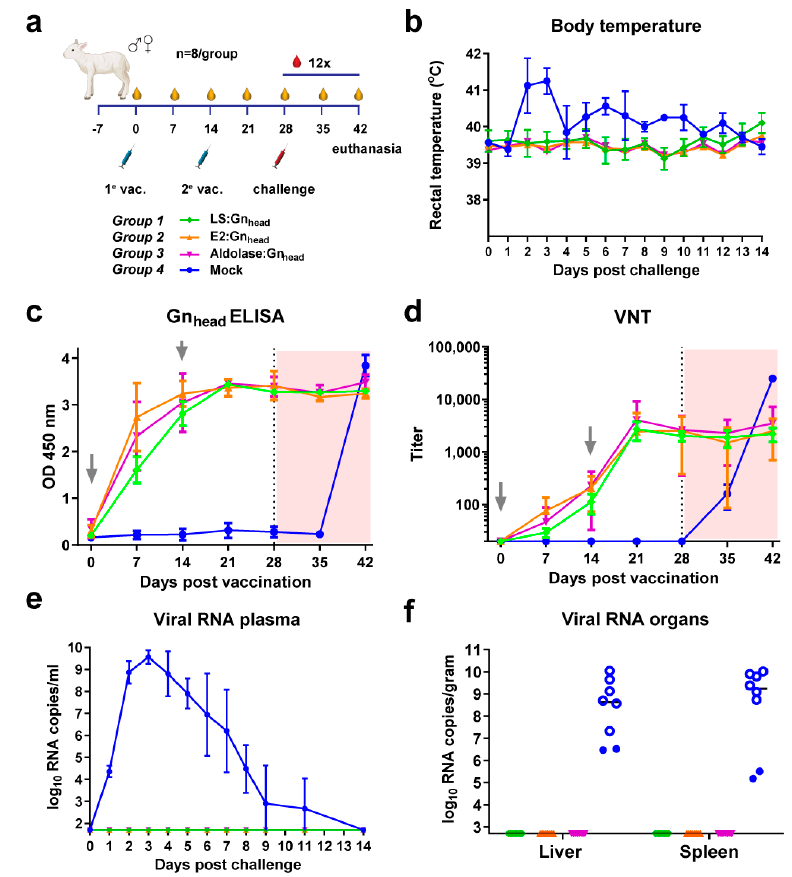
Figure 5. RVFV vaccination-challenge experiment with Gn head -coupled MPSP particles in lambs. ( a ) Schematic presentation of the vaccination regimen and vaccines. ( b ) Average rectal temperatures of vaccinated and mock-vaccinated lambs post RVFV challenge. ( c ) Gn head -specific antibody responses as determined by ELISA. ( d ) Neutralizing antibody responses in weekly-obtained serum samples. The x-axis is set to the limit of detection of the VNT and wells were considered positive when >50% inhibition of viral growth was observed. ( e ) Monitoring of viral RNA in vaccinated and mock-vaccinated lambs by RT-qPCR. Samples that tested negative are depicted at the detection limit of the PCR (1.3 log 10 RNA copies/mL) ( f ) Viral RNA in liver and spleen samples of vaccinated and mock-vaccinated lambs by RT-qPCR. Samples that tested negative are depicted at the detection limit of the PCR (2.3 log 10 RNA copies/mL). Open symbols indicate animals that succumbed or were euthanized due to the challenge infection prior to study end. Error bars in panels b, c, d, and e indicate SDs.